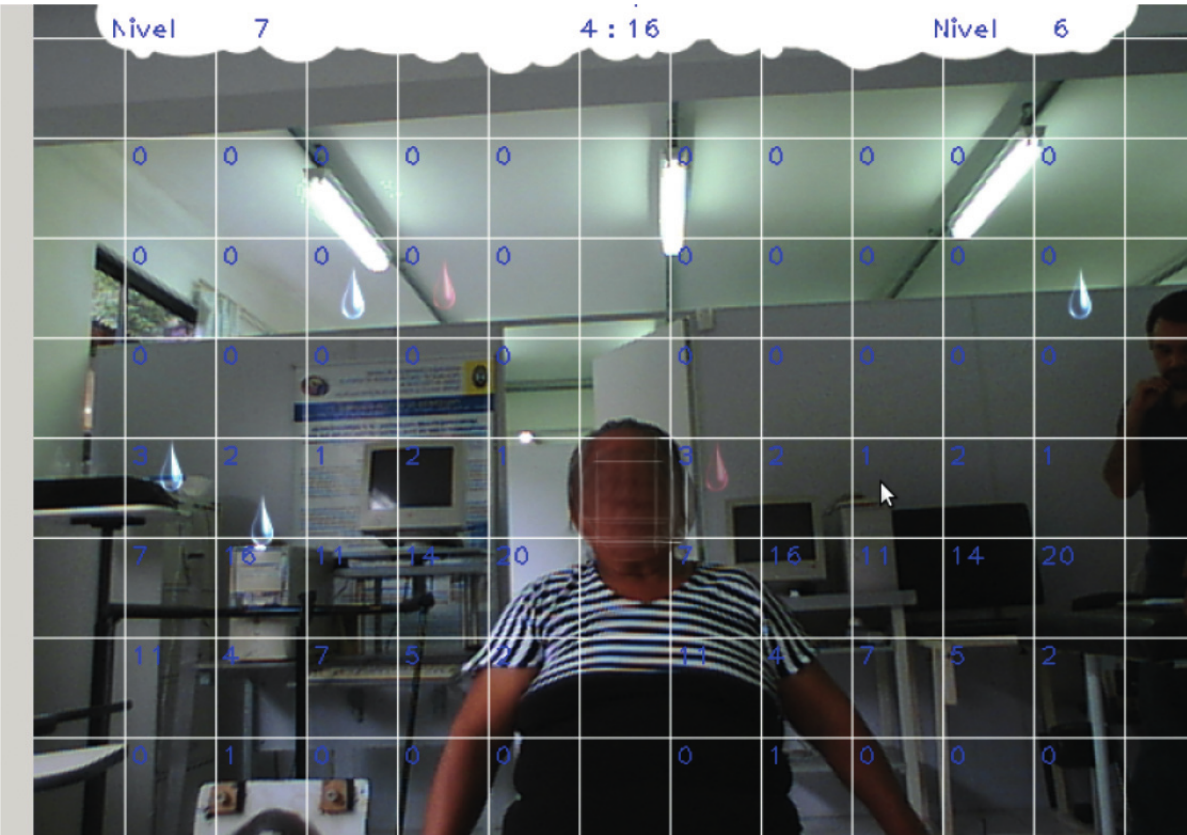
Figure 1 - Patient on Dance Rain – Serious Game Source: Research